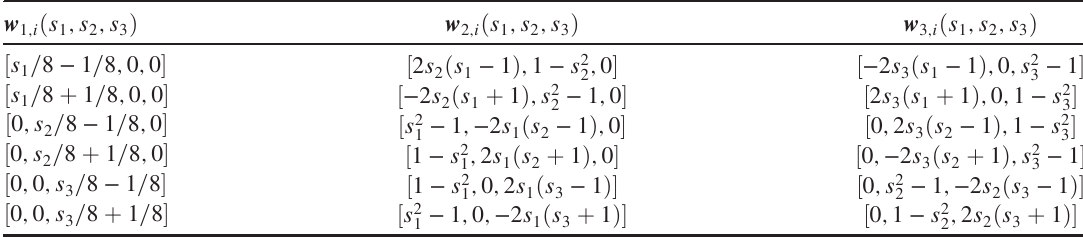
TABLE I. Shape functions for the yoke elements. Facet functions (first column) and recirculating functions (second and third